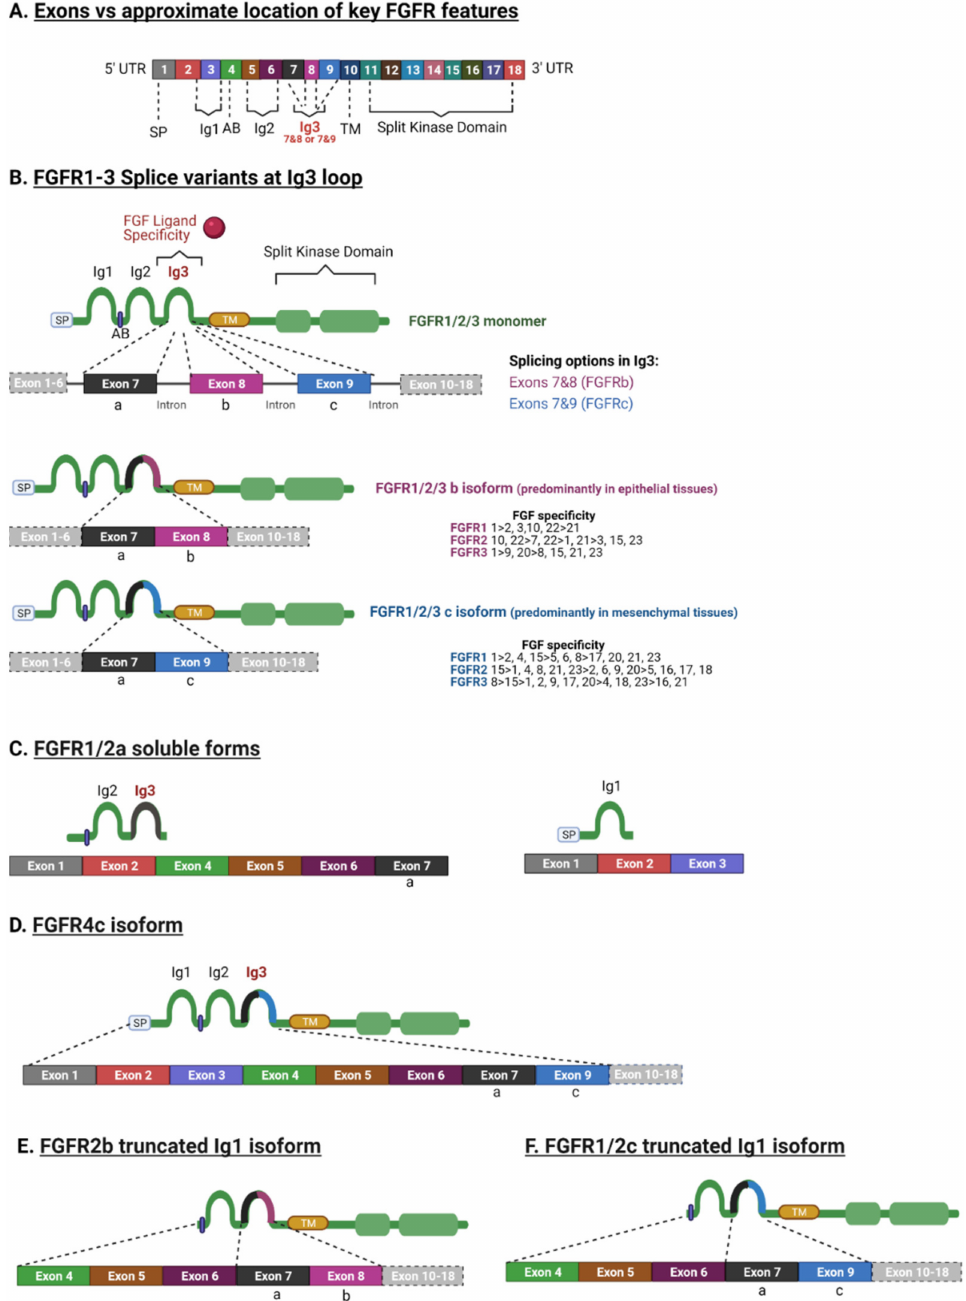
Figure 2. Key FGFR splice variants and ligand specificity. ( A ) A generalised diagram representing the key FGFR features. ( B ) Splice variant at the Ig3 loop occurs in FGFR1 –3. This splice variant is responsible for ligand binding specificity and is generated by alternative splicing at the Ig3. The first portion of the Ig3 is the exon “a” (exon 7) that is spliced to either exon “b” (exon 8) or exon “c” (exon 9) and then to the exon that encodes the TM domain. The “b” isoform is mainly expressed by epithelial tissues/cells, whereas the “c” isoform is expressed by mesenchymal tissues. FGFs have differential specificity to different isoforms. ( C ) Splice variants can generate soluble variants without TK activity, truncated to one or more Ig domains and missing the TM domain. Variants lacking the TK domain can heterodimerise with full length FGFRs to generate nonfunctional dimers and therefore act as down regulators [24]. ( D ) FGFR4 can generate a single isoform containing the “c” exon (exon 9) in the Ig3 domain. ( E ) FGFR2 can generate a splice variant missing Ig1 and Ig3 containing the “b” exon (exon 8). ( F ) FGFR1 and FGFR2 can also generate a splice variant with truncated Ig1 and Ig3 containing the “c” exon (exon 9). SP: signal peptide, Ig: Immunoglobulin, AB: acid box; TM: transmembrane domain, UTR: untranslated region. Created with BioRender.com (accessed on 26 September